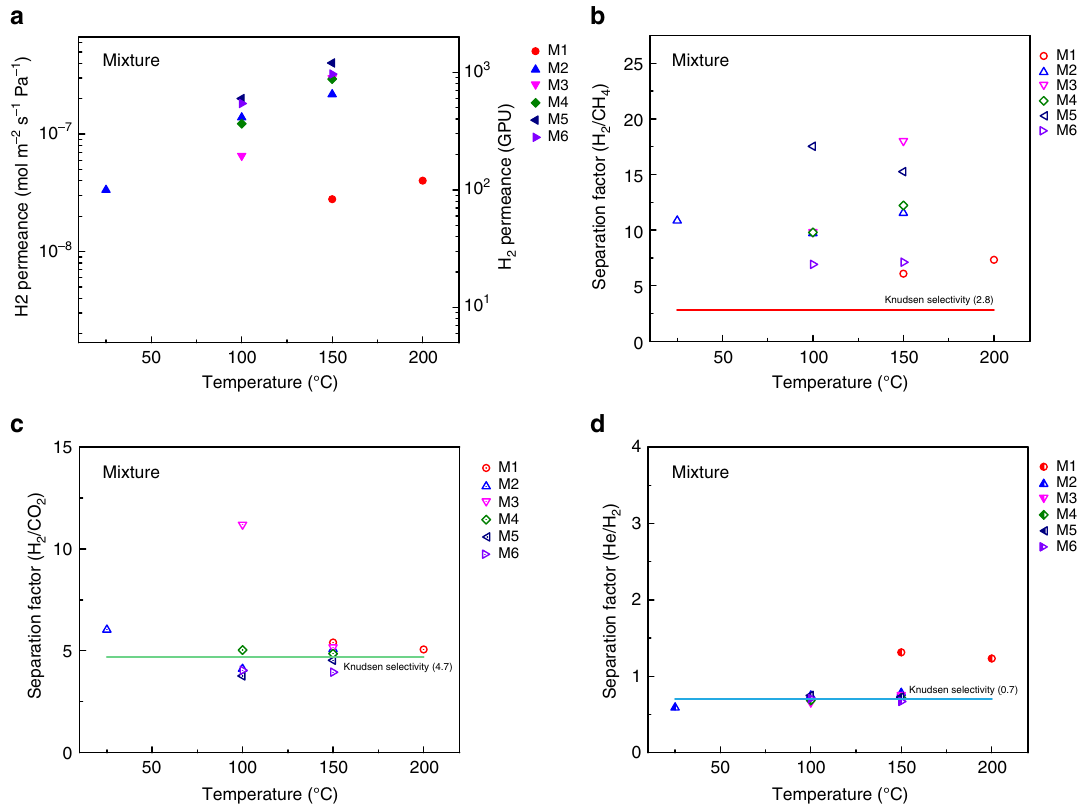
Fig. 4 The gas mixture separation performance of the intrinsic defects in graphene. a H 2 permeance from six membranes (M1 – M6) as a function of temperature when using an equimolar mixture gas feed. H 2 /CH 4 , H 2 /CO 2 , and He/H 2 separation factors as a function of temperature are shown in b , c , and d ,